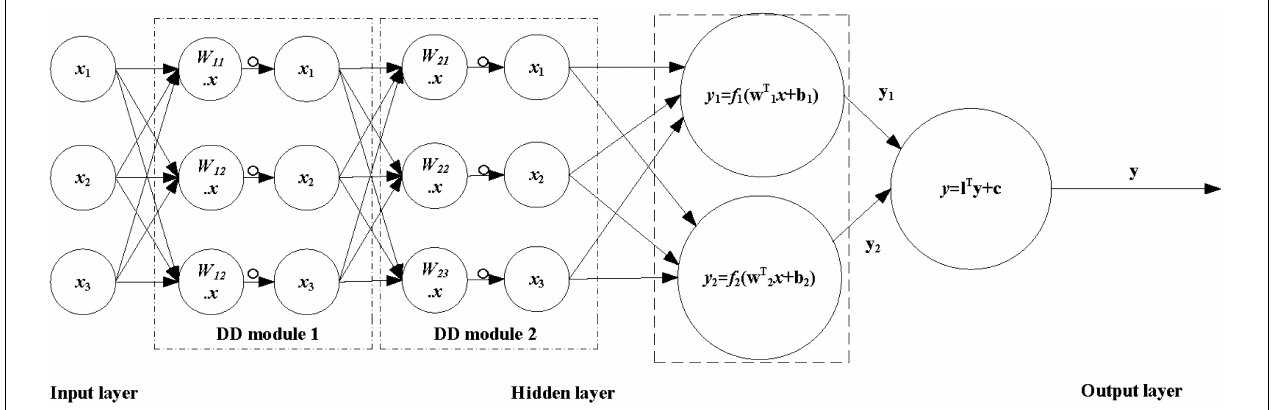
FIGURE 2 | Flowchart of artificial dendritic neural network model.